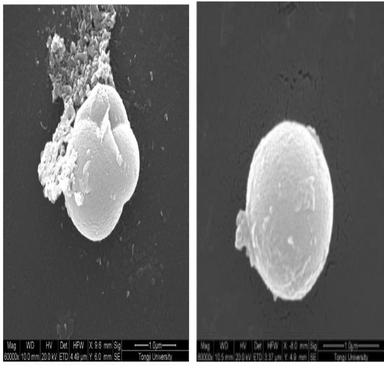
Morphology of (a) pore-expanded silica microsphere with sodium silicate adsorbed and (b) final autolytic mineral microsphere.